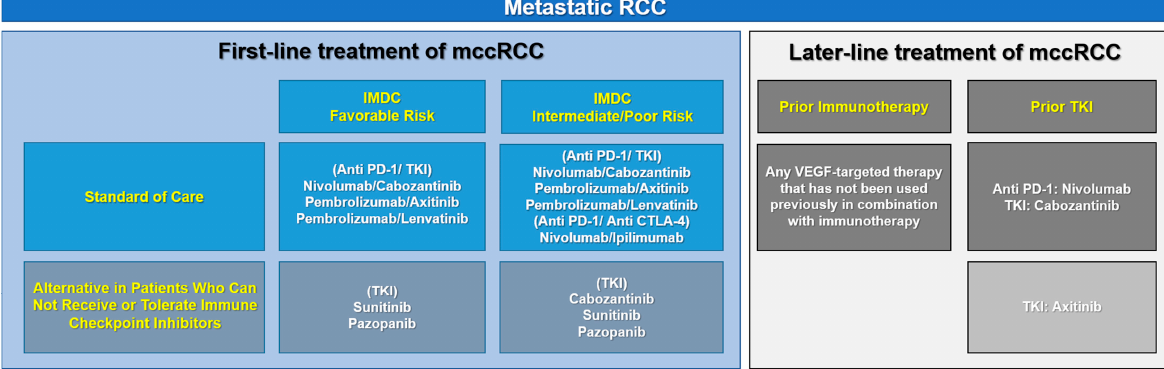
Figure 1. Management of mccRCC from the updated 2022 EAU guideline. Systemic treatment with a combination of anti-angiogenetic agents (mainly TKIs) and immune checkpoint inhibitors (mainly anti-PD-1/PD-L1/CTLA-4) is recommended for mccRCC patients. The combinations vary according to the IMDC risk stratification of RCC. mccRCC, metastatic clear cell renal cell carcinoma; EAU, European Association of Urology; IMDC, International Metastatic RCC Database Consortium; TKI, tyrosine kinase inhibitor; VEGF, vascular endothelial growth